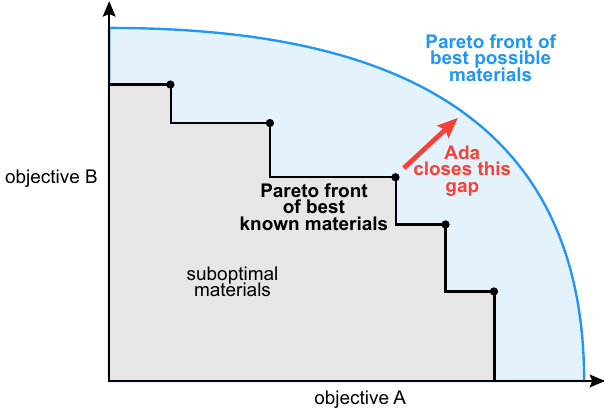
Fig. 1 A Pareto front. No single optimal material exists when searching for materials that satisfy two or more con fl icting objectives (e.g., fi lm conductivity and processing temperature). Rather, there is a set of materials that offer the best possible tradeoffs between the objectives (indicated by the blue curve). The state-of-the-art materials that offer the best known compromises between the two objectives form the experimentally observed Pareto front (black